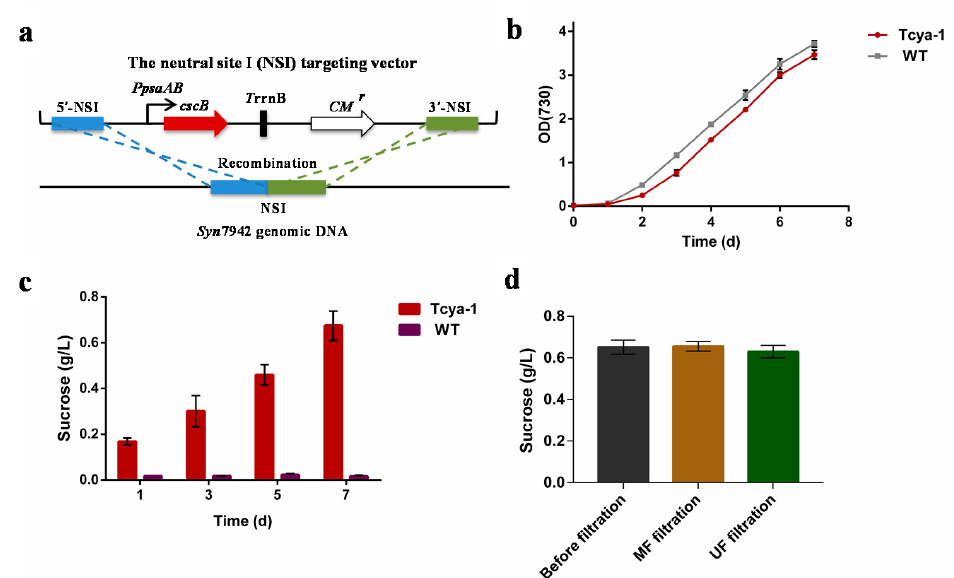
Figure 7. The separation efficiency of biosynthesis filtration system. ( a ) Schematic representation of sucrose transporter gene cscB with constitutive promoter PpsaAB integration into the Syn 7942 genome. The T rrnB and CM represent trrnb transcription terminator and chloramphenicol resistance gene, respectively; ( b ) growth curves of Tcya-1 and wild-type Syn 7942 (WT); ( c ) Sucrose yields of Tcya-1 and wild-type Syn 7942 (WT); ( d ) the level of sucrose from cyanobacteria cultures before and after filtration with an MF or UF membrane under a feed pressure of 1 bar. Error bars represent the standard deviations of